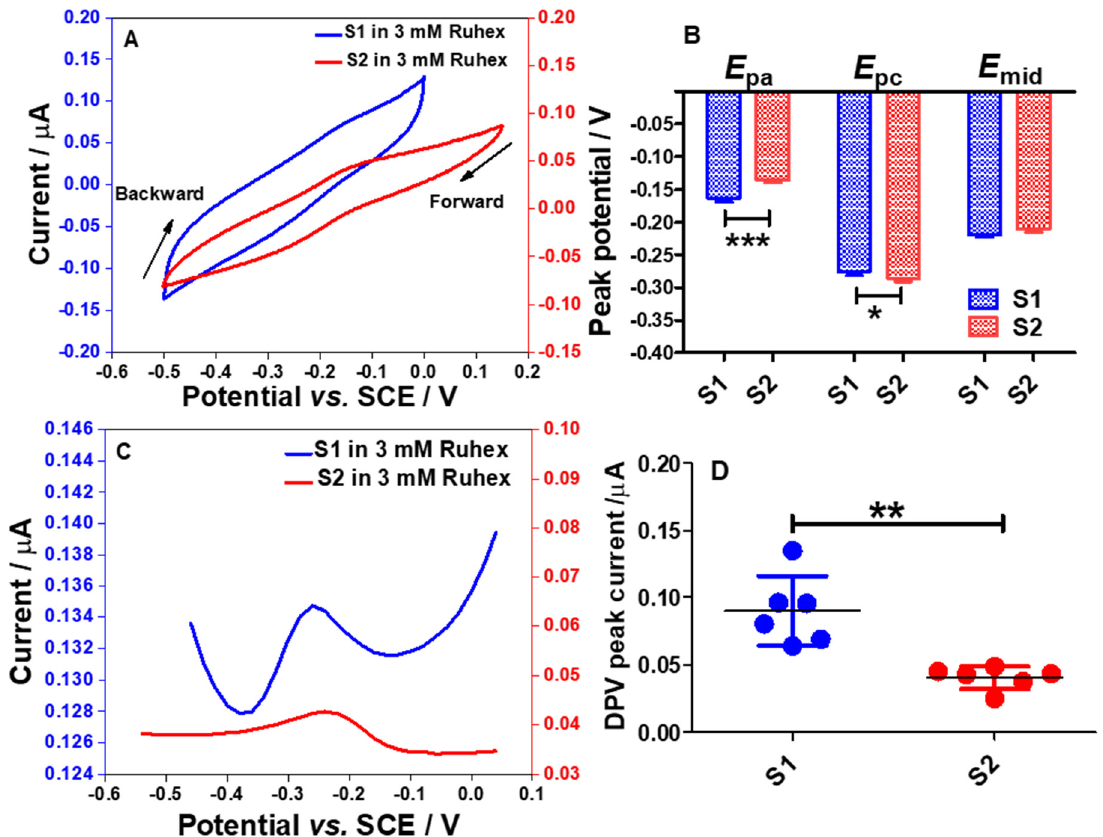
Figure 9. Cyclic voltammogram responses (3rd cycle) recorded using electrode strips; S1 and S2 electrodes ( A ) in 3 mM Ruhex, dissolved in 0.1 M PB solution, by cycling the potentials from 0.2 to − 0.5 V vs. SCE at 100 mV s − 1 . ( B ) Comparison of the E pa , E pc and E mid between S1 and S2 electrodes. Statistical analyses were achieved using two-way ANOVA, followed by a Bonferroni test. Data shown as mean ± S.D., n = 4, * denotes p < 0.05 and *** denotes p < 0.001. ( C ) Differential pulse voltammograms (DPVs) obtained in the 3 mM Ruhex solution, by scanning the potentials between − 0.6 and 0.2 V vs. SCE at modulation amplitude of 50 mV, step potential of 20 mV, modulation time of 50 ms and interval time of 500 ms. ( D ) Comparison of DPV peak currents between S1 and S2 electrodes. Statistical analysis was performed using an unpaired student t -test. Data shown as mean ± S.D., n = 6 and ** denotes p < 0.01.